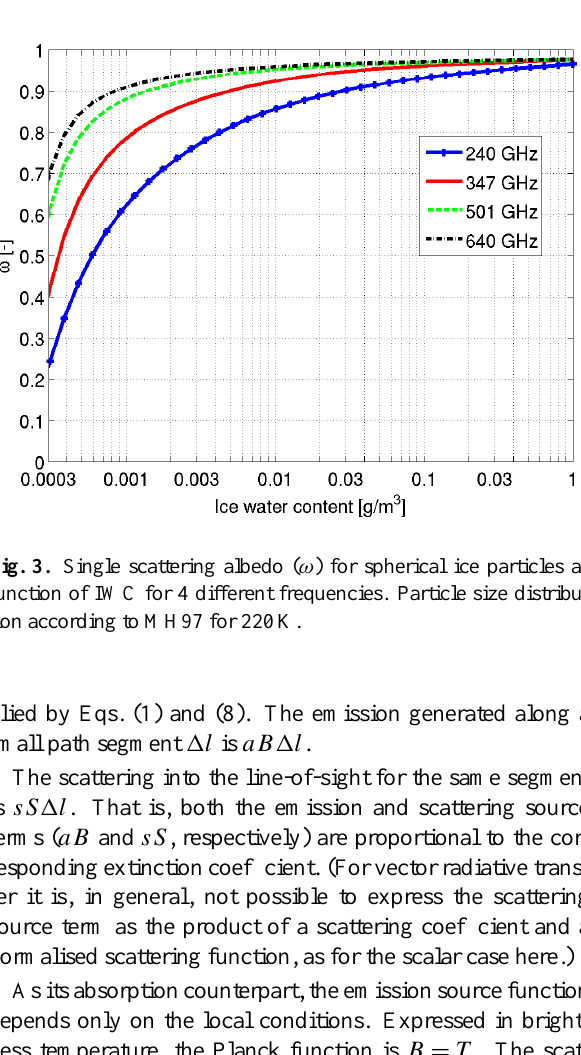
Fig. 3. Single scattering albedo ( ω ) for spherical ice particles as function of IWC for 4 different frequencies. Particle size distribution according to MH97 for 220 K .